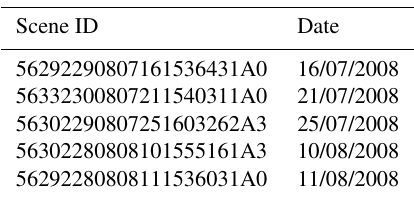
Table 1. SPOT5-HRG scene identification numbers and dates of image